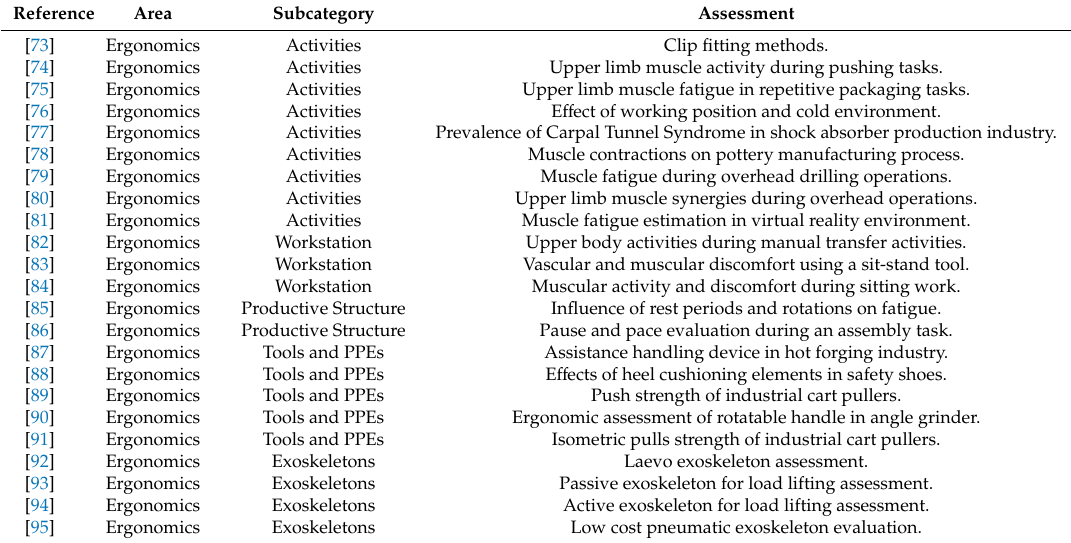
Table 1. Applications of electromyography in production